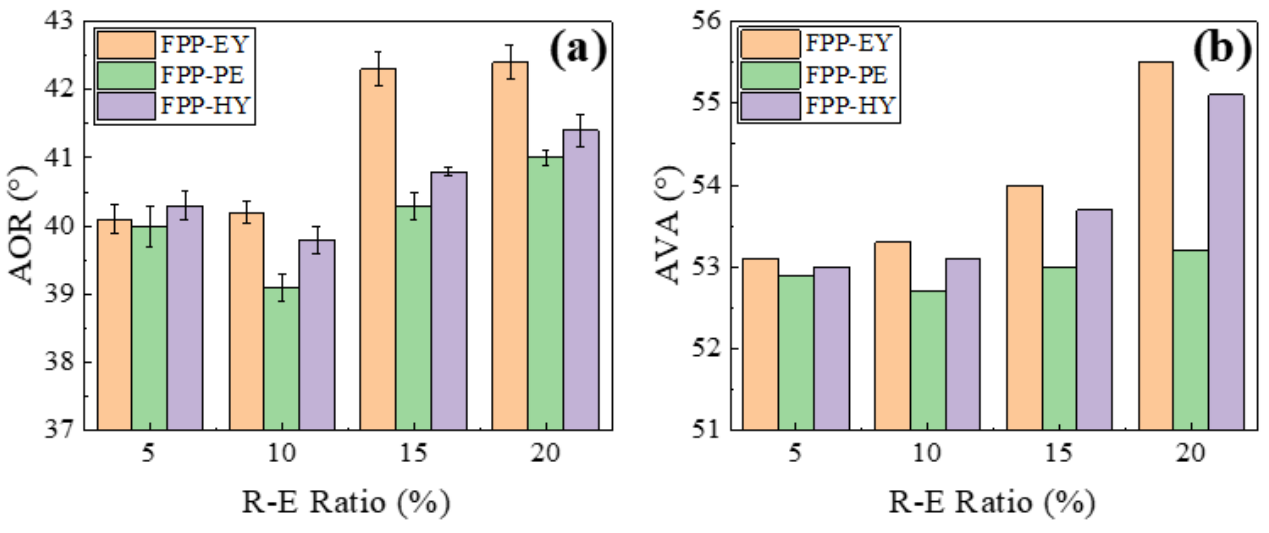
Figure 6. Effects of encapsulating materials at LOA of 0.8%. ( a ) AOR; ( b ) AVA.